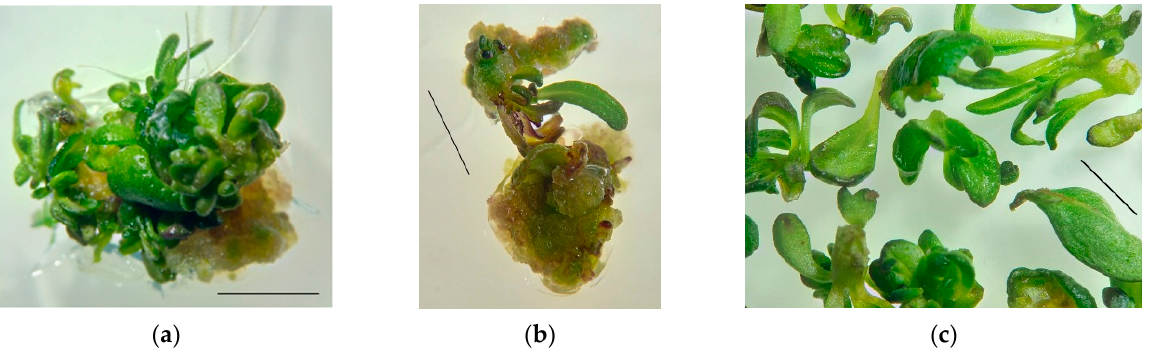
Figure 2. Appearance of the primary callus and regenerant plants of S. hortensis : ( a ) callus from cotyledon leaves, ( b ) callus from hypocotyls, and ( c ) regenerant plants. Bars—0.5 cm. After 2–3 weeks of explant cultivation, meristematic foci were formed on the callus tissue sites, and small shoots of normal morphology, hyperhydric teratomas, and roots were formed due to organogenesis.